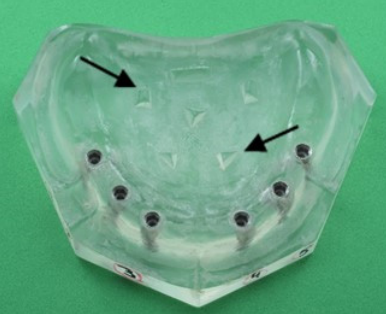
Figure 1. Master model with six analogs located in bilateral symmetry to the midline.